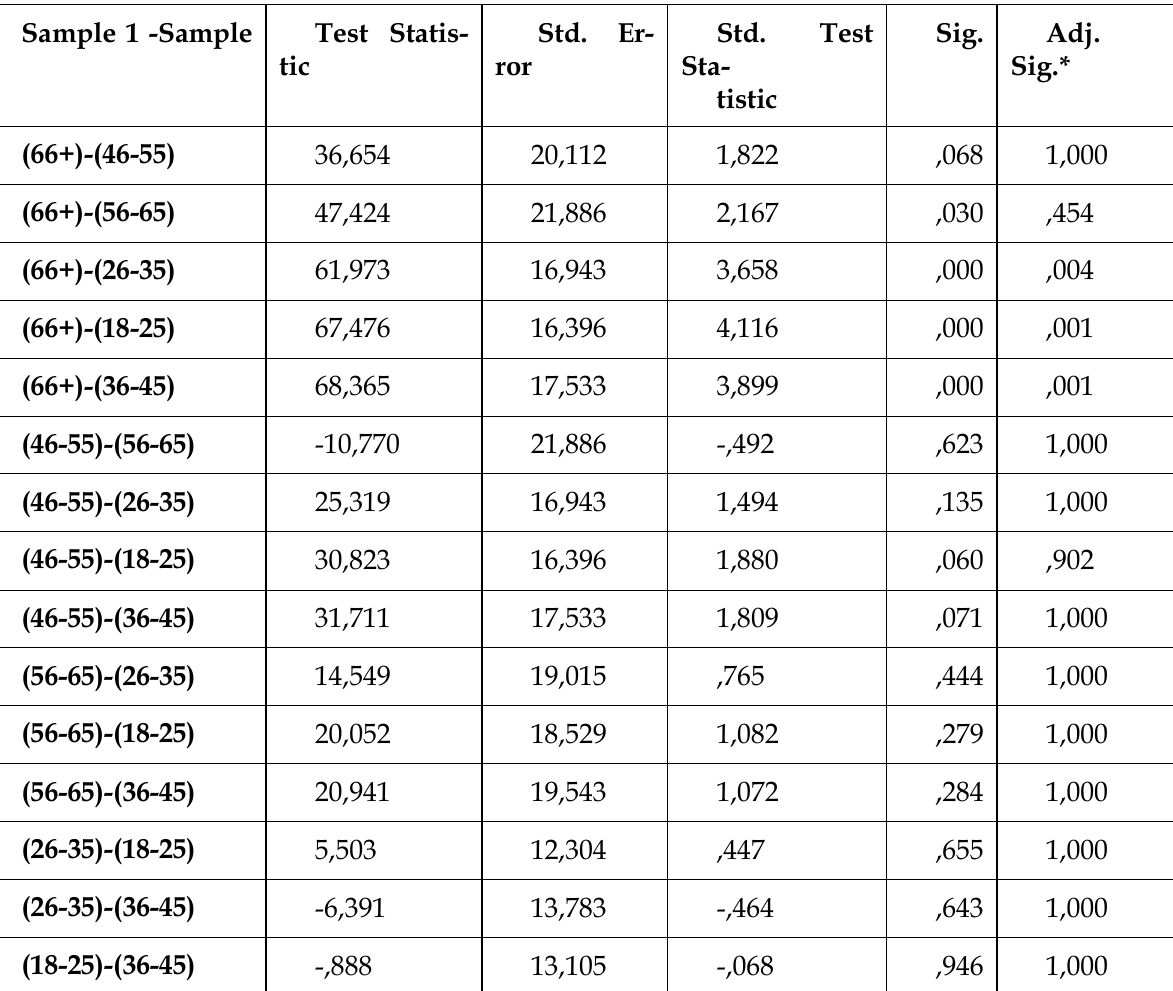
Table 26. Willingness to use the Digital Health Centre and age. Pairwise comparison (Bonferroni). Each row tests the null hypothesis that the Sample 1 and Sample 2 distributions are the same. Asymptotic significances (2-sided tests) are displayed. *Significance values have been adjusted by the Bonferroni correction for multiple